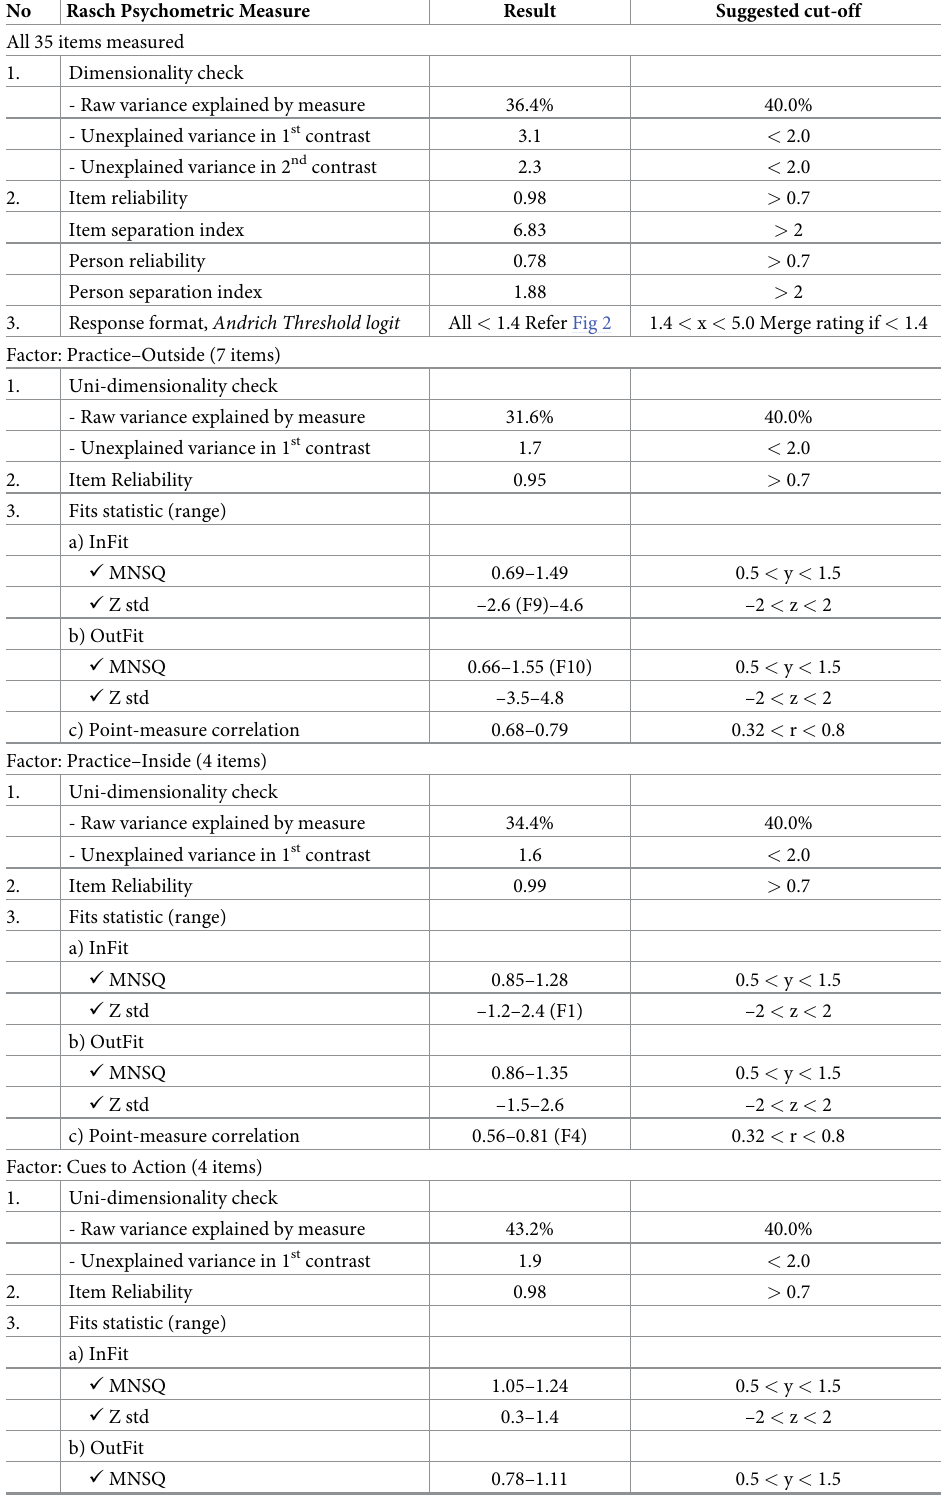
Table 5. Result from item response theory